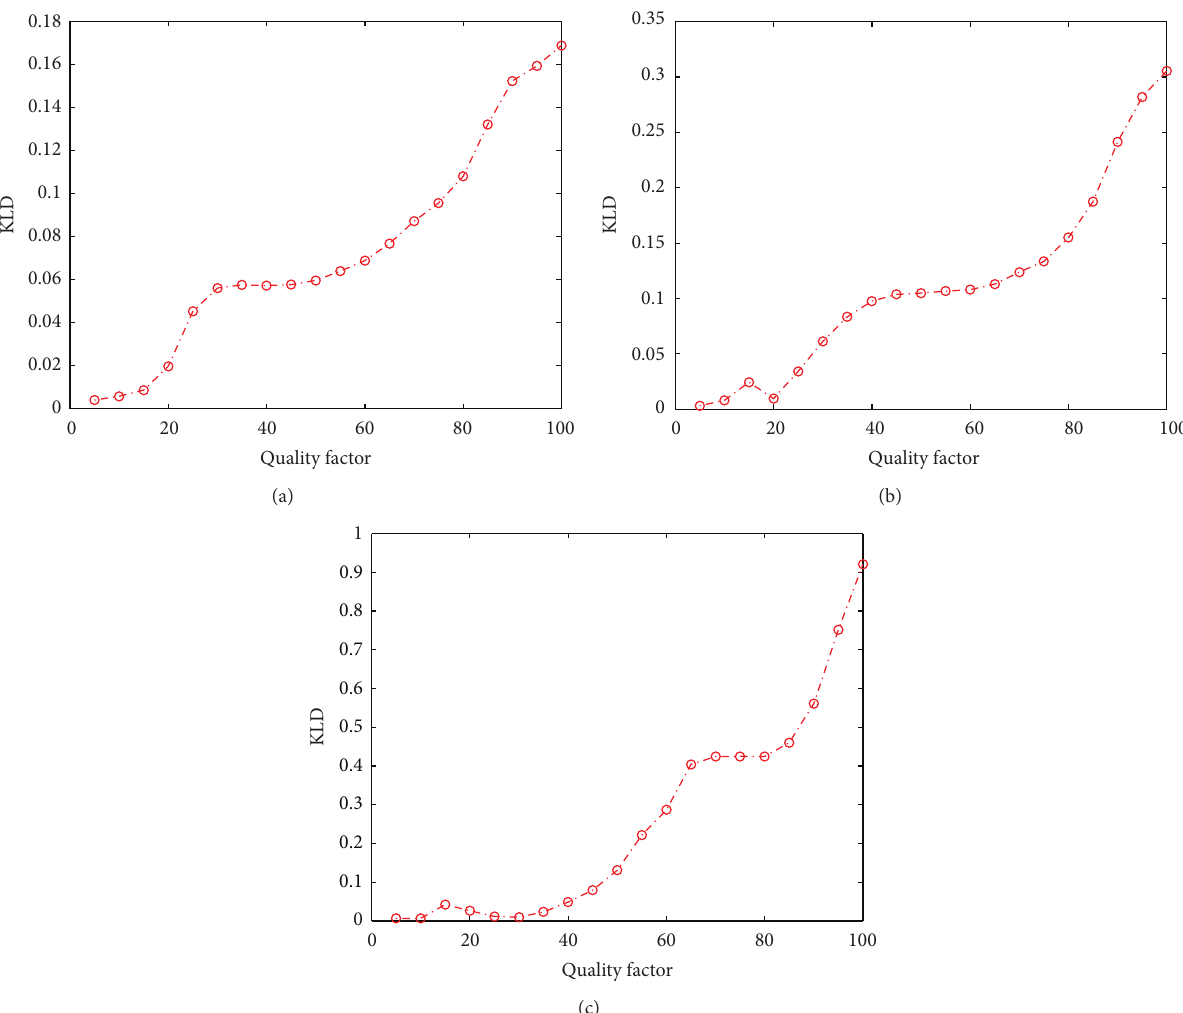
and Θ attack under different predefined robustness settings (a) for Rbst QF = 70 (b) for Rbst QF = 80 post pri